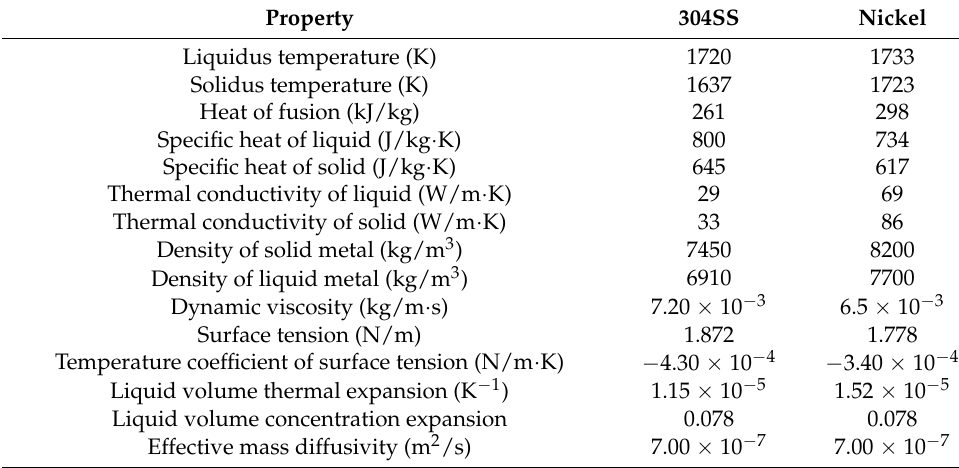
Table 4. Thermal and physical properties of the materials